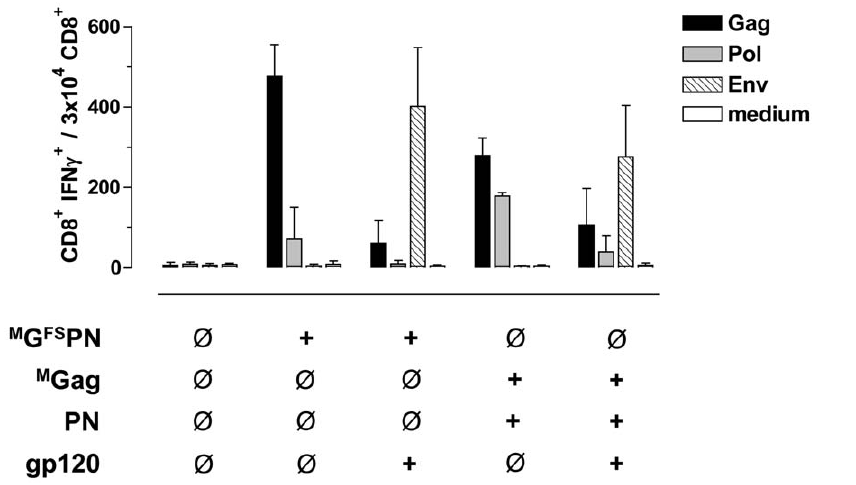
Figure 4. Effect of co-immunization with Gag-Pol-Nef and gp120 on Gag- and Pol-specific CD8 + T cell responses. BALB/c mice (n=6 per group) were i.m. inoculated ( + ) with M G FS PN; or equimolar mixtures of M G FS PN and gp120; M Gag and PN; or M Gag, PN, and gp120. After 12 days, spleen cells were isolated and tested for specific cellular immune responses by measuring IFN c production after stimulation with Gag (black), Pol (grey) or Env (hatched) specific peptides as described in Fig. 3. Cell culture medium served as a negative control. Data shown are representative of two experiments.